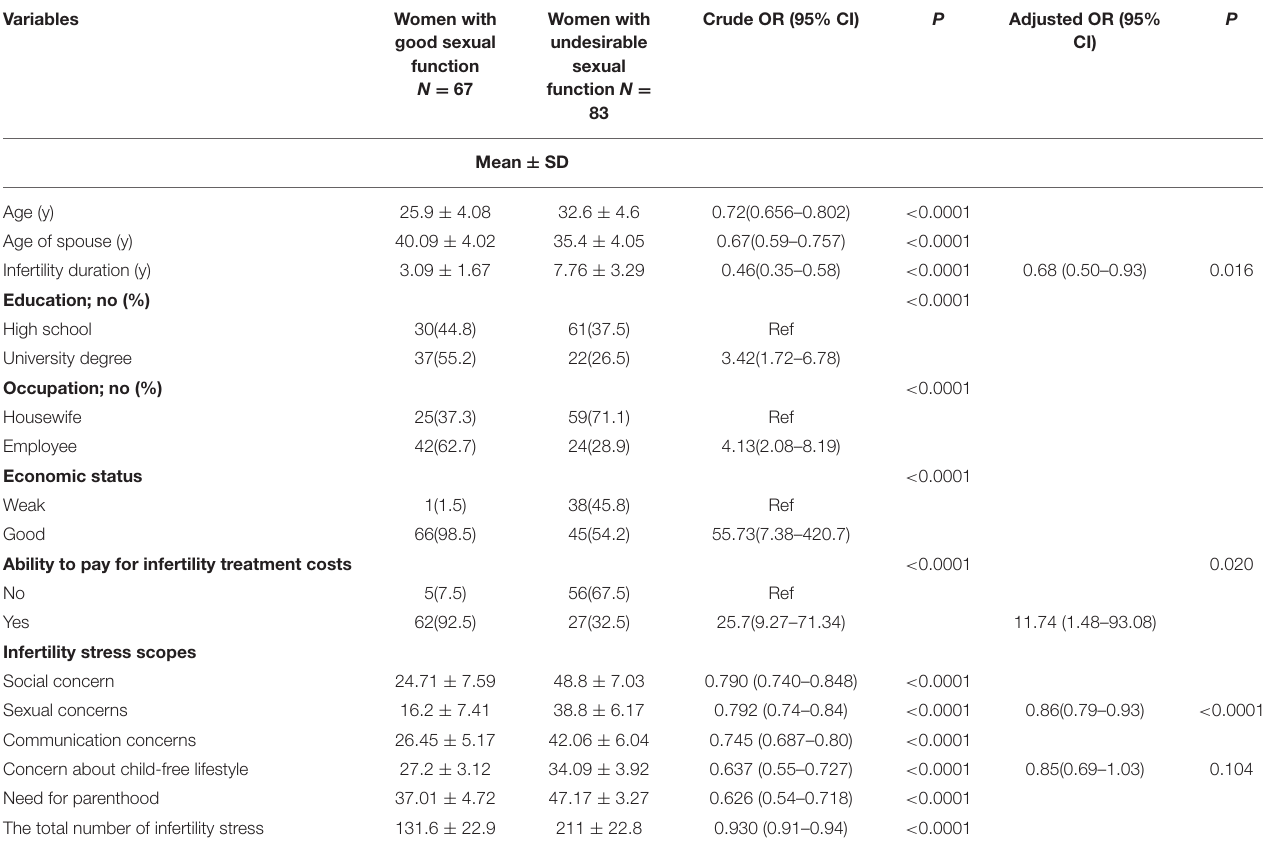
TABLE 4 | Results of univariate and multiple logistic regression models for predicting good sexual function in infertile